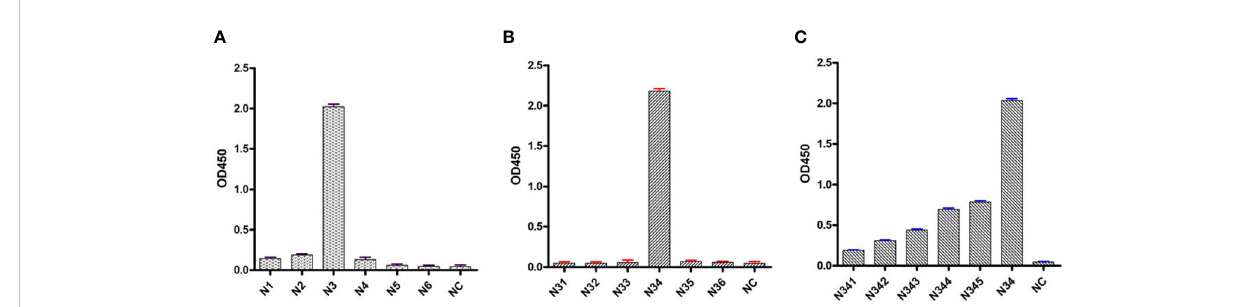
FIGURE 6 Indirect enzyme-linked immunosorbent assays (ELISA) analysis of synthesized peptides. (A) : indirect ELISA for the fi rst series of synthesized peptides. N1 – N6 represent truncated peptides covering the porcine reproductive and respiratory syndrome virus (PRRSV) N protein sequence from amino acids 1 – 25, 20 – 44, 39 – 63, 58 – 82, 77 – 101, and 96 – 123, respectively. NC: negative control. (B) : indirect ELISA for the second series of synthesized peptides covering the peptide N3. N31: 39 – 54; N32: 41 – 56; N33: 43 – 58; N34:45 – 60; N35: 47 – 63. NC: negative control. (C) : indirect ELISA for the third series of synthesized peptides covering the peptide N34. N341: 45 – 55; N342: 46 – 56; N343: 47 – 57; N344: 48 – 58; N345: 49 – 59; N346: 50 – 60. NC, negative